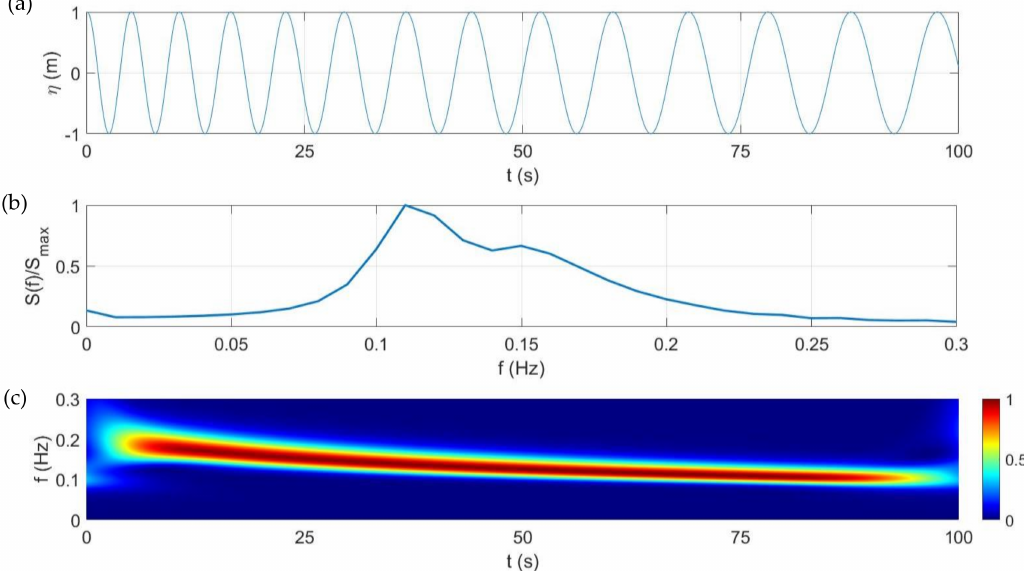
Figure 2. Nonstationary wave signal time series ( a ) and corresponding spectra using di ff erent methodologies: ( b ) dimensionless Fourier spectrum; ( c ) dimensionless wavelet